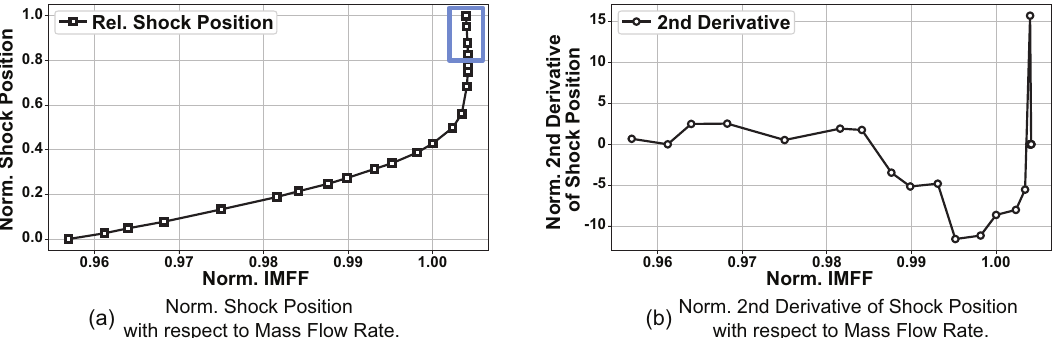
Figure 10. Relative shock displacement and its second derivative. The data are from fan 1’s design speed